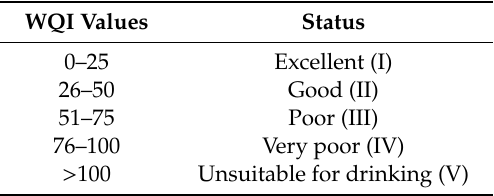
Table 3. Water quality status based on Water Quality Index